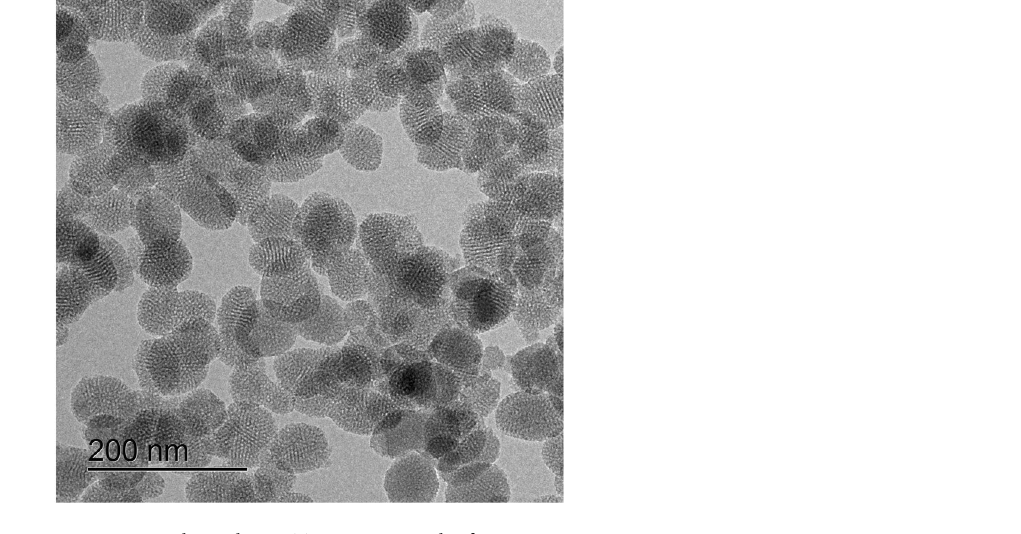
Figure 2. High resolution TEM micrograph of